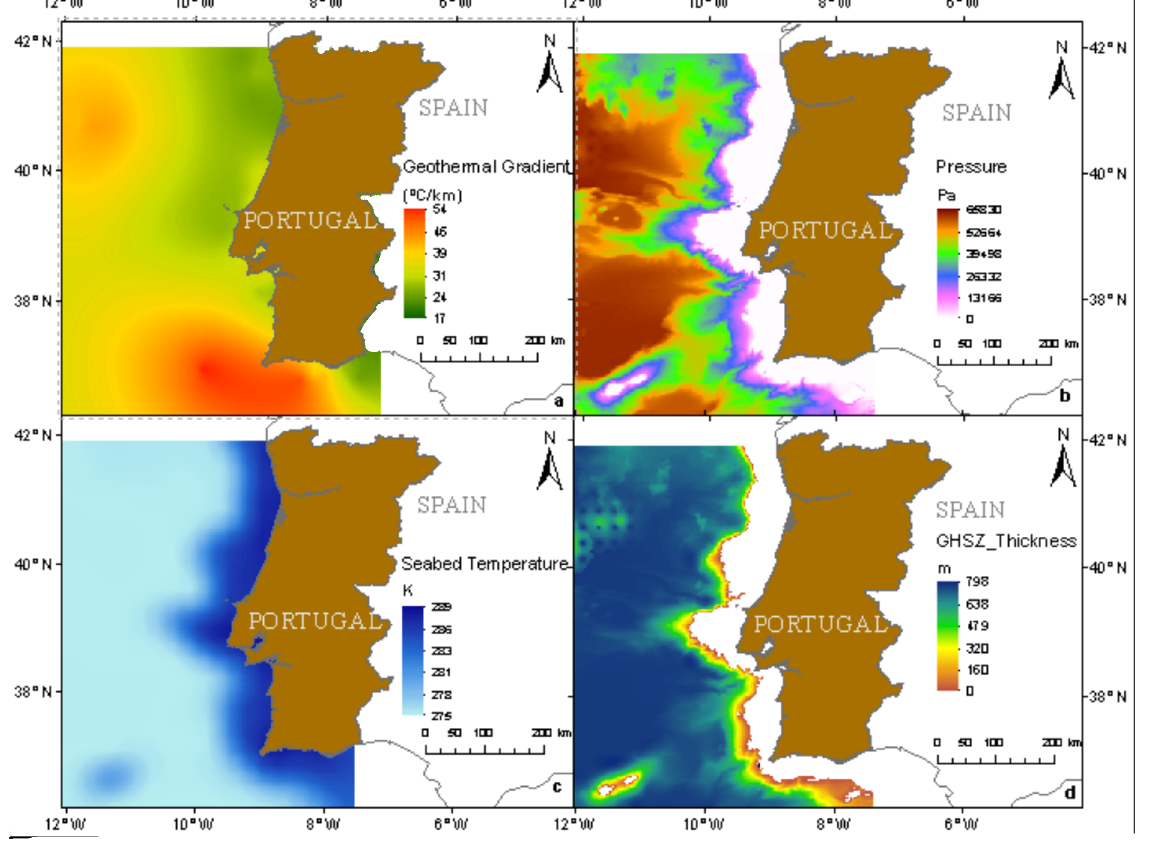
Figure 4. Raster datasets. ( a ) Updated geothermal gradient; ( b ) Hydrostatic pressure; ( c ) Seabed temperature; ( d ) GHSZ thickness ( L sz